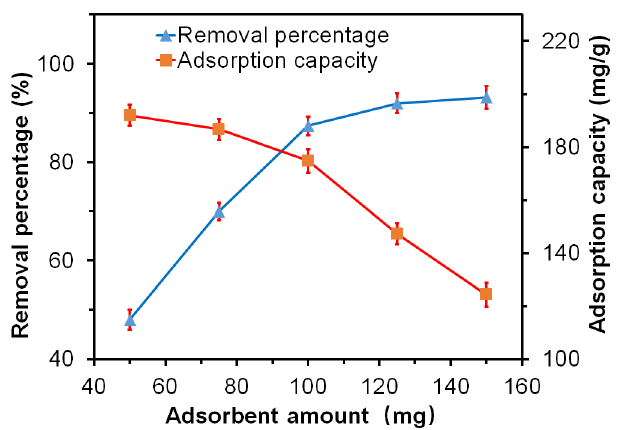
Figure 8. Influence of the adsorbent amount on the removal percentage and adsorption capacity of the GO ‐ CNT/AC composites [Conditions: MB solution amount = 100 mL, MB solution concentration = 200 mg/L, pH = 7, adsorption time = 300 min, CNT concentration = 3 mg/mL, adsorbent amounts were 50, 75, 100, 125 and 150 mg, respectively].